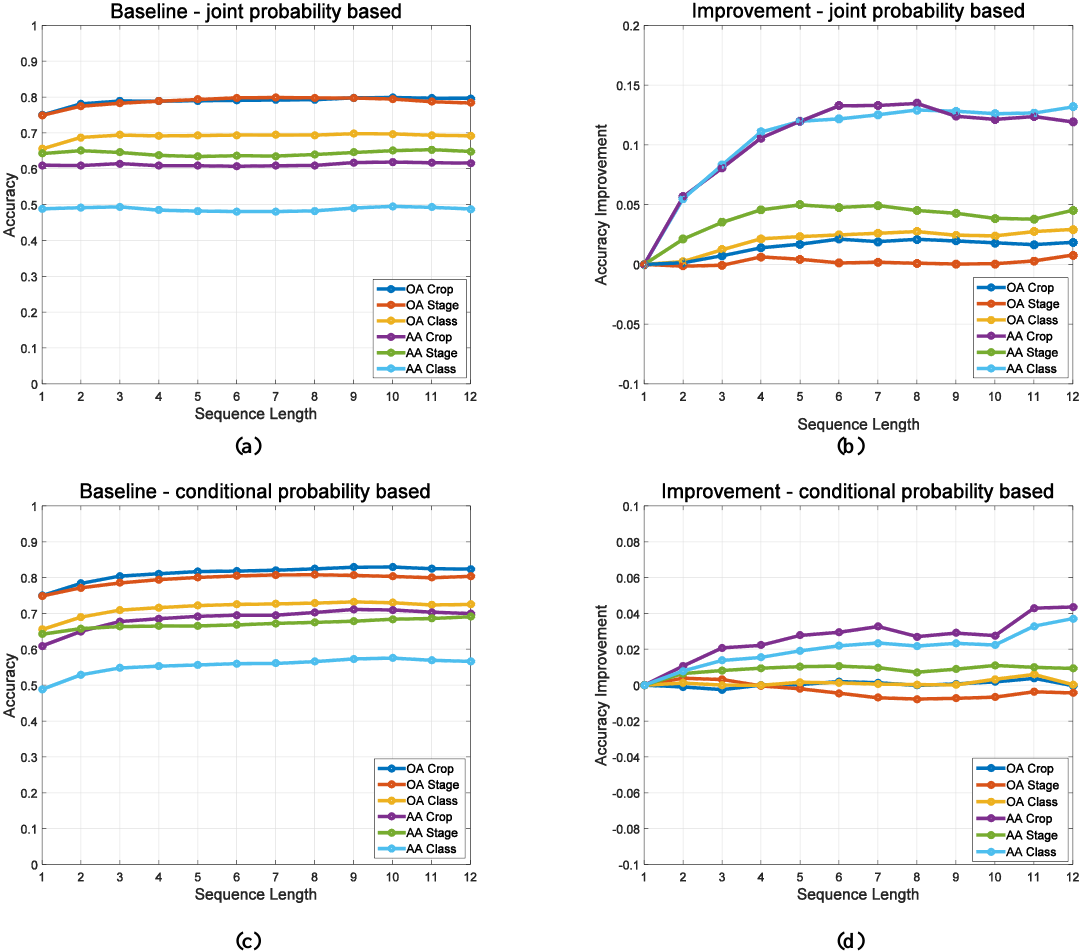
Figure 4. Accuracies of the baseline (a) of the proposed method and the accuracy improvement (c) for different sequence